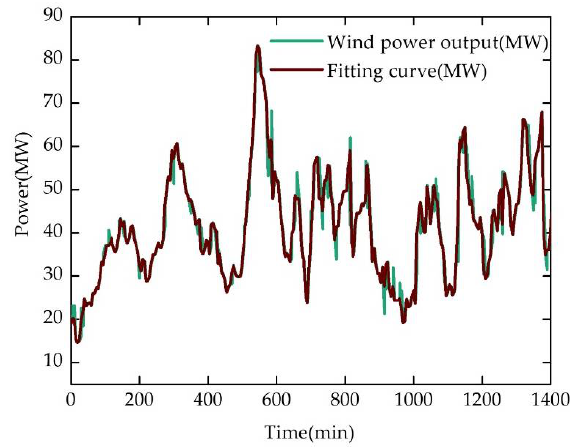
Figure 10. Twenty-four hour wind power output tracking.